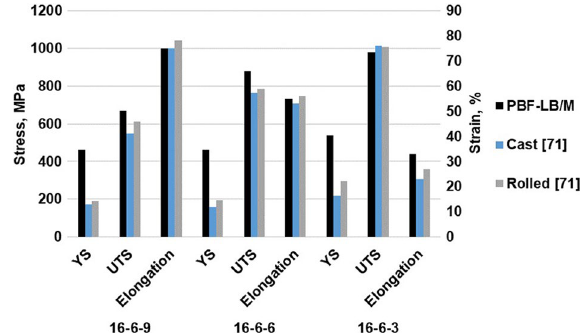
Figure 6. Strength and ductility of the steels with varying Ni content. Data for as-cast and rolled conditions were recompiled from 71